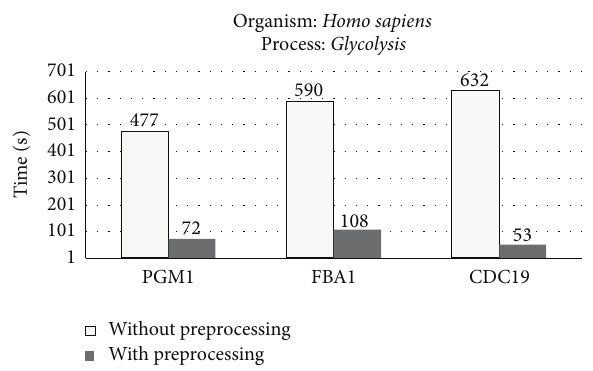
Figure 5: Runtimes with and without preprocessing for the PGM1 , FBA1, and CDC19 genes involved in the Glycolysis process of the Homo sapiens organism.